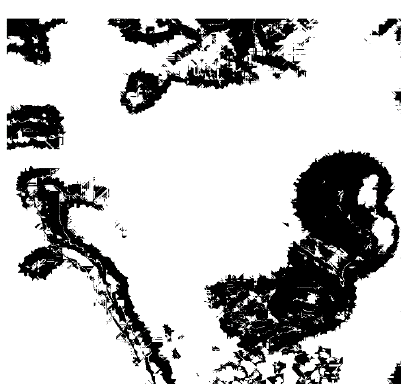
( d ) Figure 4. Schematic diagram of four direction scanning binary map. ( a ) is the vertical scanning map; ( b ) is the horizontal scanning map; ( c ) is the 45° left scanning map; ( d ) is the 45° right scanning map.